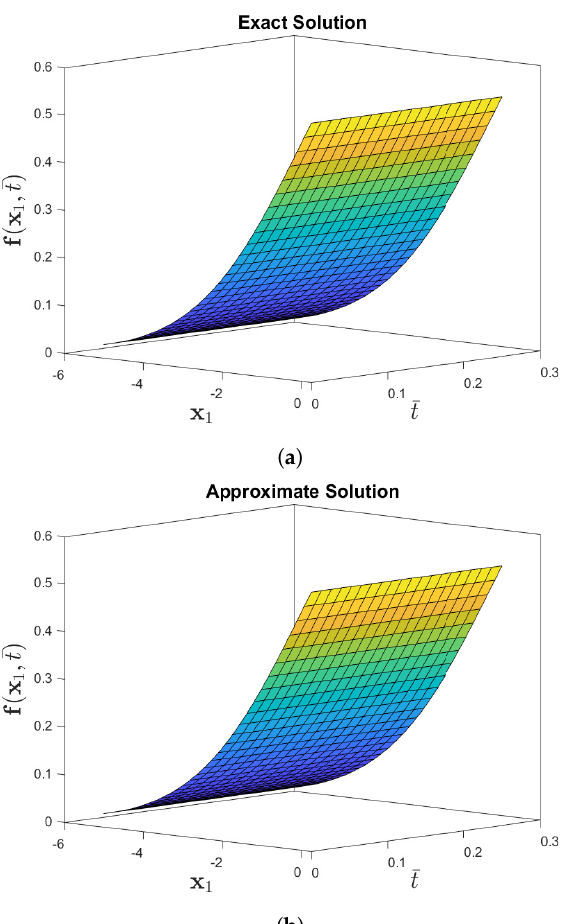
Figure 10. Numerical-behavior of exact and approximate solution to the f ( x 1 , ¯ t ) for Problem 4 when the parameters are θ = 1, β = 1, and ϕ =